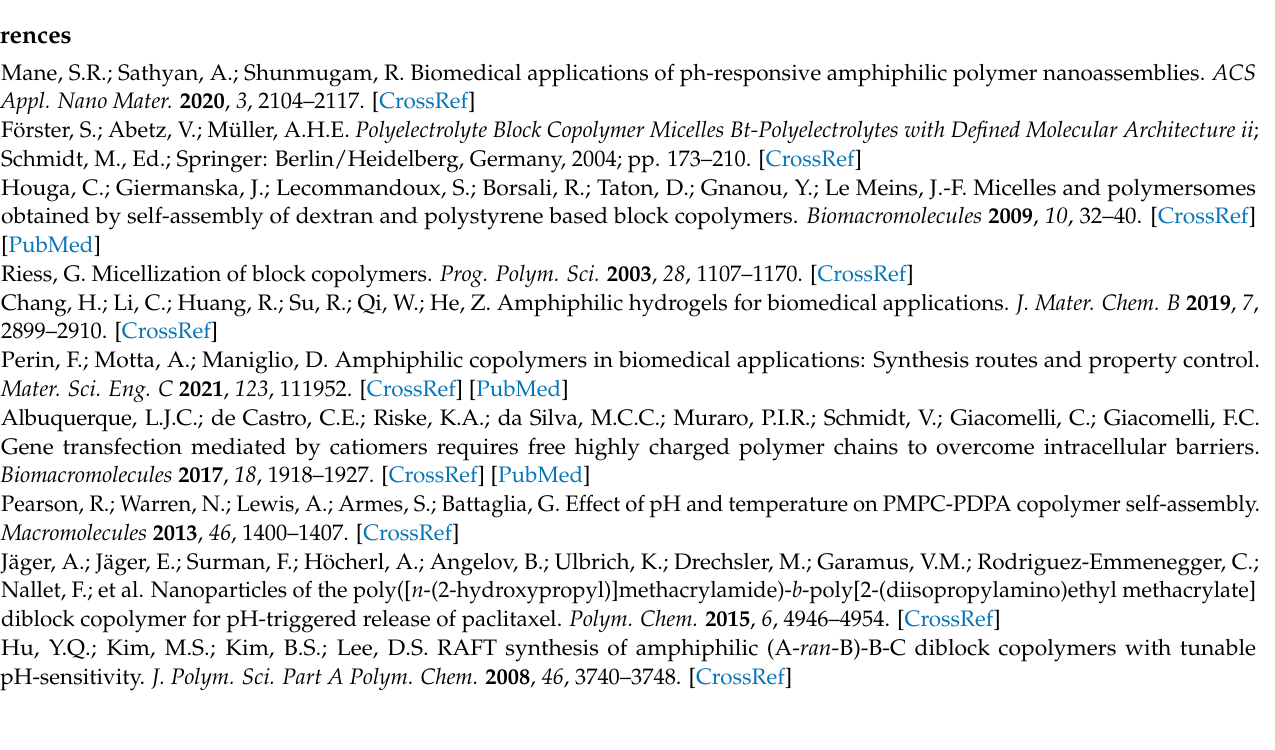
Figure S5. Hydrodynamic radius ( R h ) distributions of (a) P(MPC/DPAEMA50) 107 , (b) PMPC 52 - b -PDPAEMA 56 , and (c) an equimolar mixture of the random and block copolymers in acidified dimethylsulfoxide at 25 ◦ C. Figure S6. Fluorescence peak intensity ratio ( I 3 / I 1 ) of pyrene in the presence of (MPC/DPAEMA50) 107 ( (cid:3) ) and PMPC 52 - b -PDPAEMA 56 (o) in 0.1 M NaCl plotted against the polymer concentration ( C p ). I 3 and I 1 are the fluorescence intensities of the third and the first vibronic peaks, respectively, in the pyrene emission spectra recorded at the excitation wavelength of 334